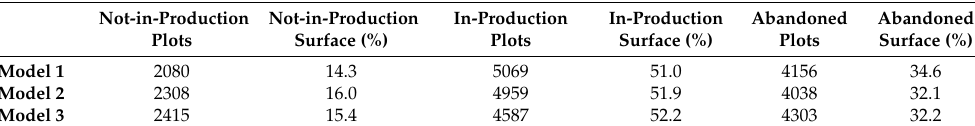
Table 3. Classification results of each model used.